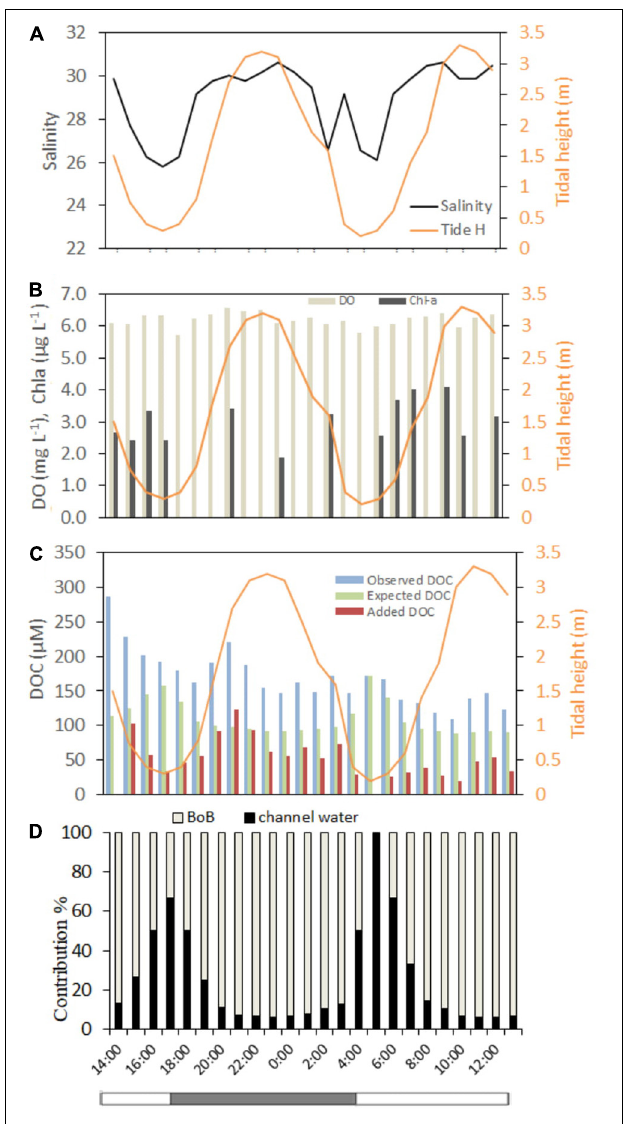
FIGURE 5 | Hourly distribution of (A) salinity and tidal height (m), (B) DO (mg L − 1 ), Chl-a ( µ g L − 1 ), and (C) DOC ( µ M) during the 24-hr observation in the Saptamukhi estuary (point SM). (D) Tidal contribution (%) of channel water and water from Bay of Bengal (BoB) were